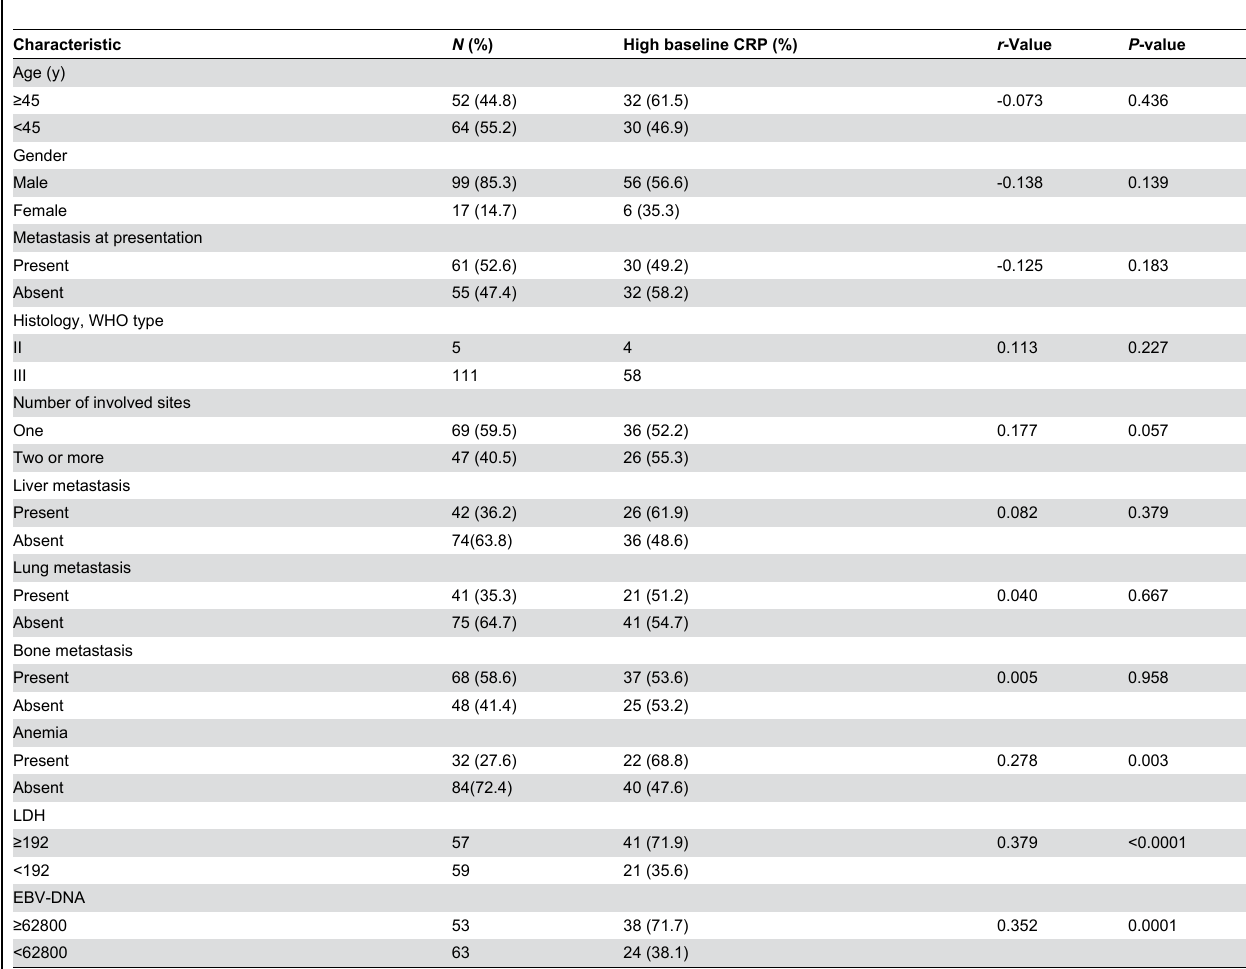
Table 1. Characteristics of patients with metastatic nasopharyngeal